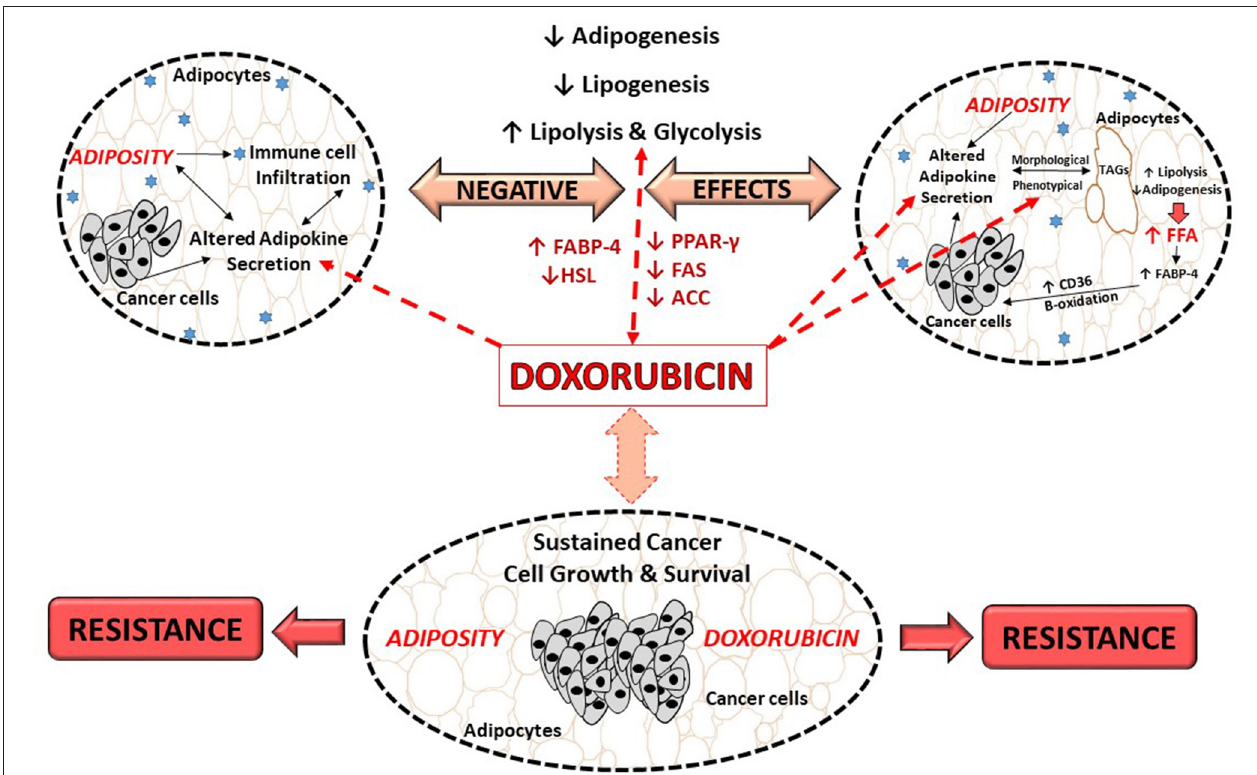
FIGURE 3 | Proposed role of doxorubicin in an obesogenic breast cancer model. ACC, Acetyl-CoA carboxylase; CD36, fatty acid translocase; FFA, free fatty acids; FABP, fatty acid binding protein; FABP-4, fatty acid binding protein-4; FAS, fatty acid synthase; HSL, hormone sensitive lipase; PPAR- γ , peroxisome proliferator-activated receptor- γ ; TAGs,